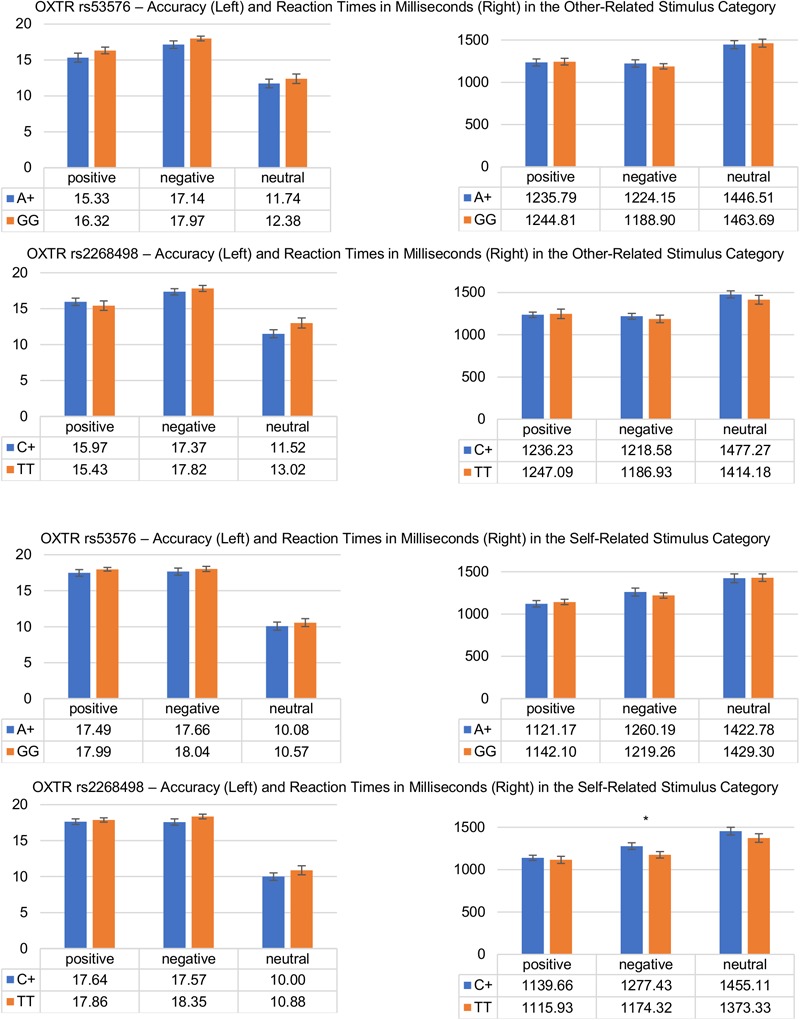
Differences in response accuracy and reaction times during the affective evaluation of other-related (upper) and self-related (lower) stimuli as a function of OXTR genotype (rs53576 and rs2268498). Vertical bars denote ±SE (∗p ≤ 0.05).